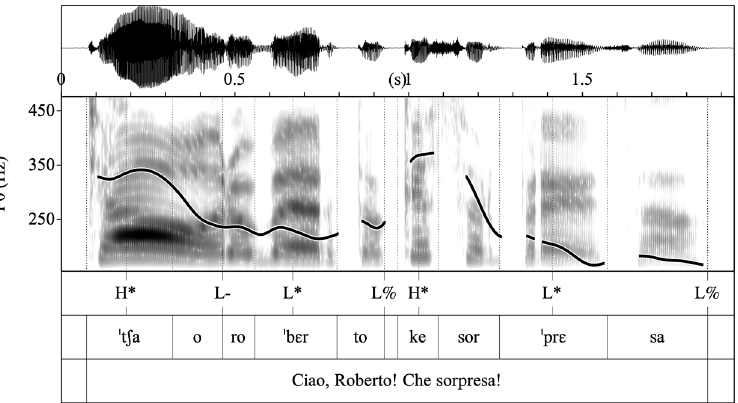
Figure 23. Waveform, spectrogram and F0 trace of the what -exclamative Ciao, Roberto! Che sorpresa! in